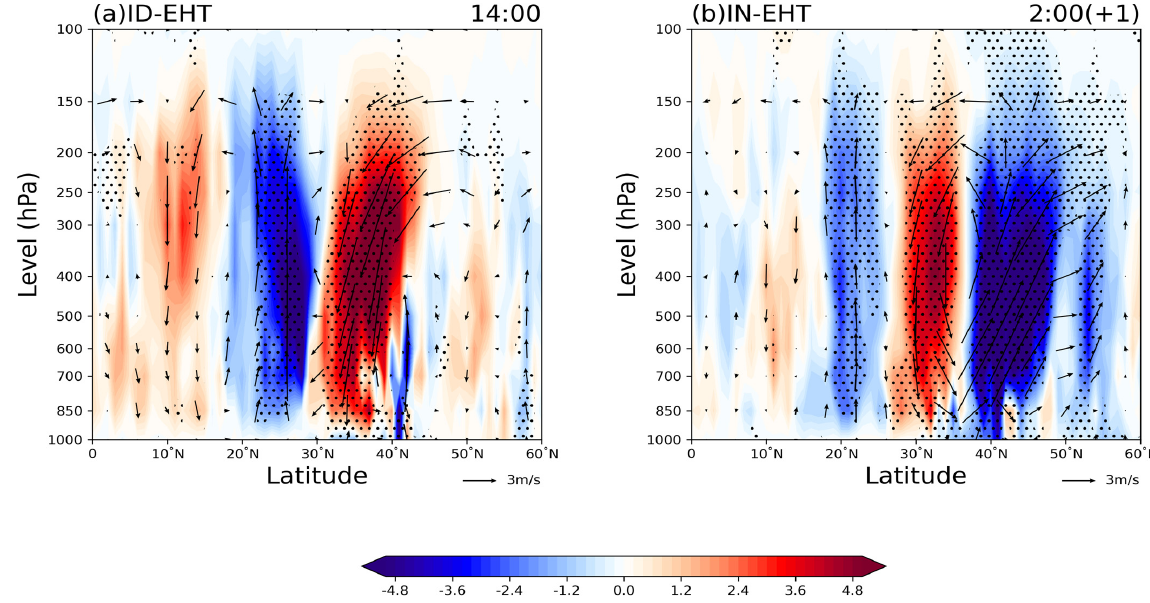
Figure 5. Composite anomalies of meridional vertical winds (arrows, units: pa/s, averaged from 110° E to 120° E, the vertical component is amplified 100 times) and vertical motion (shading, units: pa/s) at 14:00 ( a ) for ID-EHT and at 2:00 ( b ) on the next day for IN-EHT. Black dots indicate the anomalies significant at the 95% confidence level.